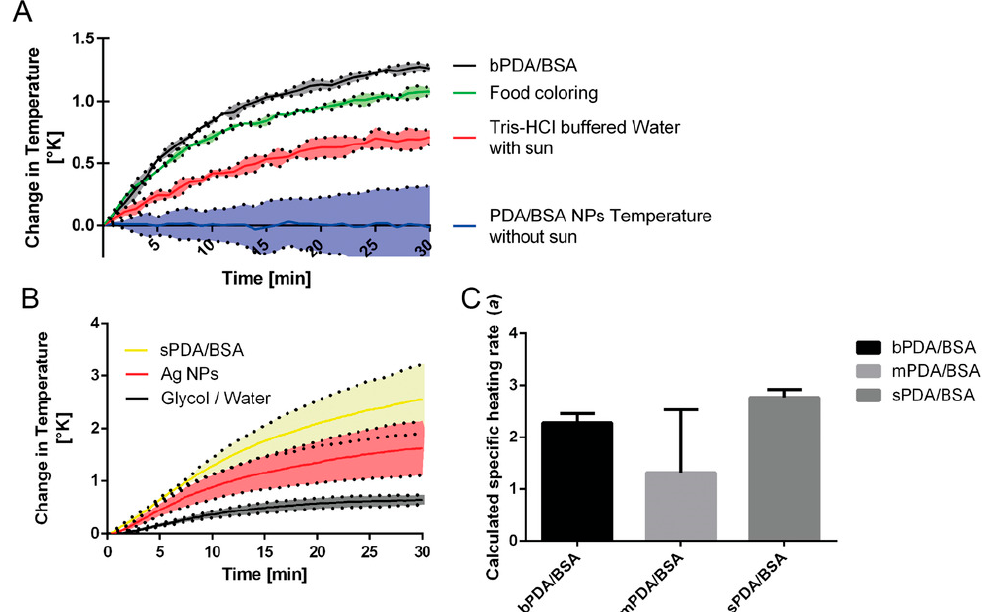
Figure 4. ‘Big’ PDA NPs containing BSA (bPDA/BSA, black line) exhibited superior heating abilities of the solar fluid in comparison to micron-sized soot particles (food coloring, green line) and solar fluid (TRIS-HCl-buffered water) without any addition (red line) ( A ). ‘Small’ PDA/BSA NPs (sPDA/BSA, yellow line) exhibited an increased heating ability of the solar fluid in comparison to silver NPs (Ag NPs, red line) and plain solar fluid (glycol/water, black line) ( B ). Calculated specific heating rate of three different sizes of PDA NPs containing BSA: ‘big’ PDA/BSA NPs (bPDA/BSA), ‘medium’ PDA/BSA NPs (mPDA/BSA), and ‘small’ PDA/BSA NPs (sPDA/BSA) ( C ). From reference [59]. Reprinted with permission from Wiley.